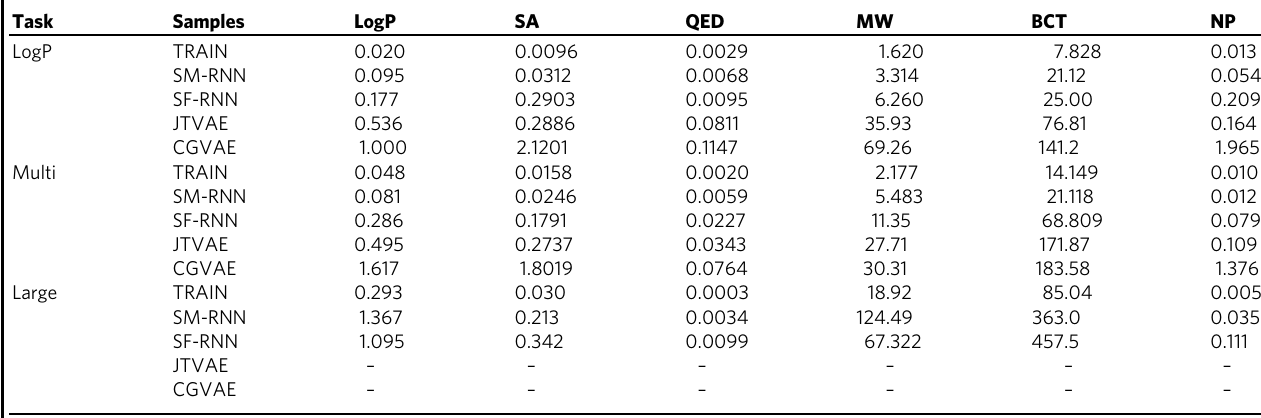
Table 2 Wasserstein distance metrics for LogP, SA, QED, MW, BT, and NP between molecules from the training data and generated by the models for all three